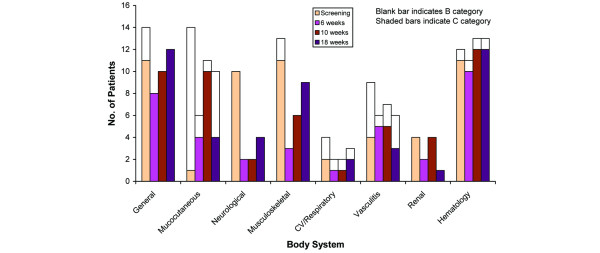
Frequency comparison of BILAG B- and C-level activities for each body system at screening, 6, 10 and 18 weeks.